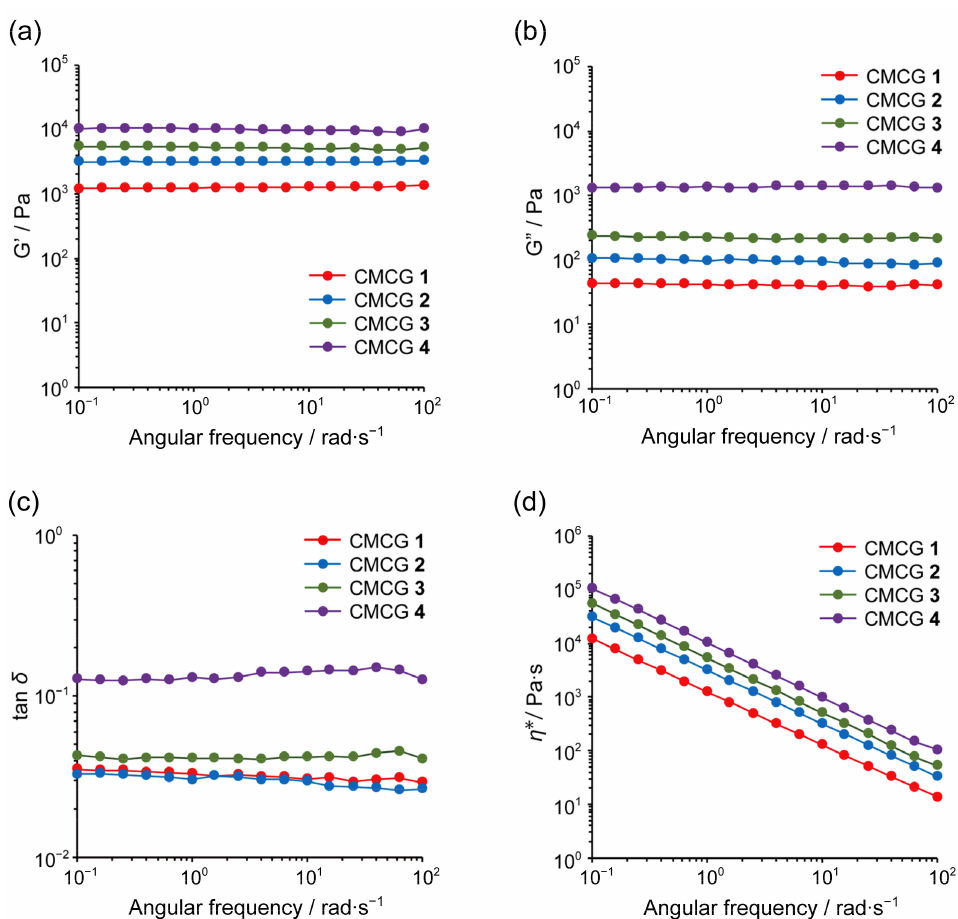
Figure 12. Rheological properties of CMCG at 298 K following swelling and saturation with PBS. The ( a ) storage modulus (G (cid:48) ), ( b ) loss modulus (G”), ( c ) tan δ (= G”/G (cid:48) ), and ( d ) complex viscosity ( η * )